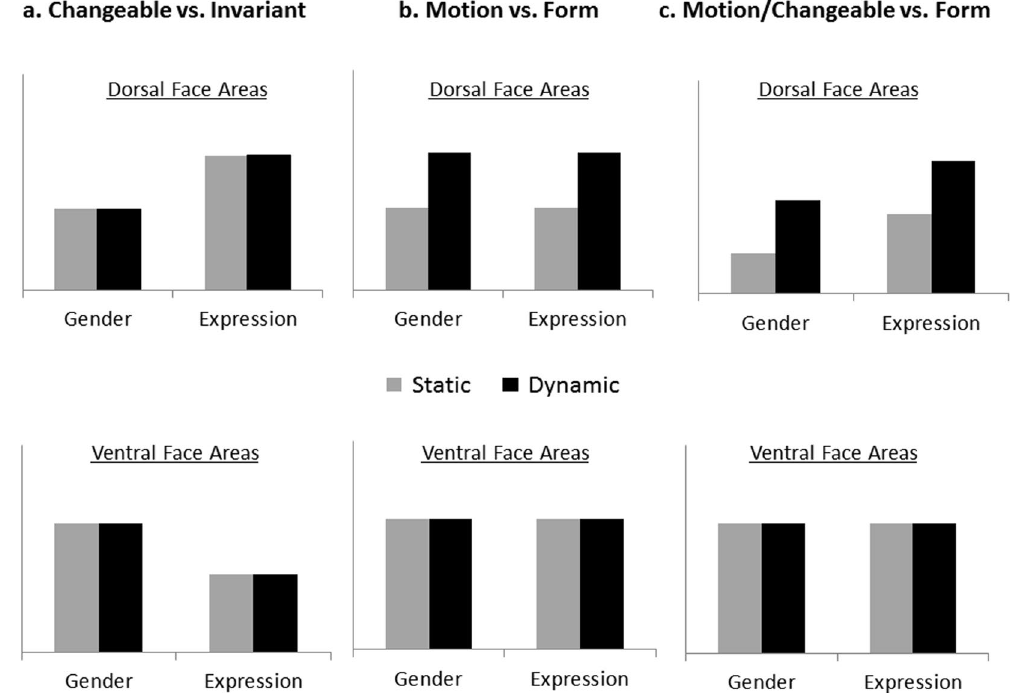
Figure 4. Three alternative predictions. ( a ) The primary division of labor between the dorsal and ventral face areas is to changeable and invariant aspects, as proposed by the current face processing neural model 1,4 . ( b ) The primary division of labor is to motion and form processing. c. An integrated model in which the dorsal face areas are sensitive to both face motion and changeable facial aspects and the ventral face areas extract form information from dynamic and static faces for both invariant and changeable